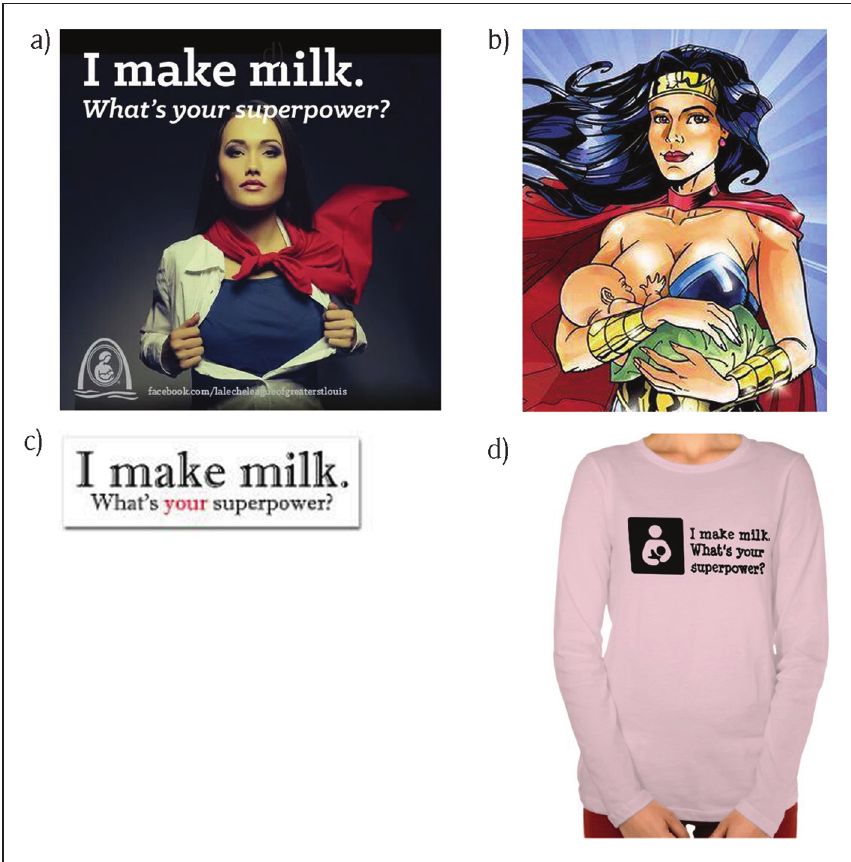
Figure 4: Milk-making Superpower (Source: LLL, unknown, l-shop, unknown; circu- lated online